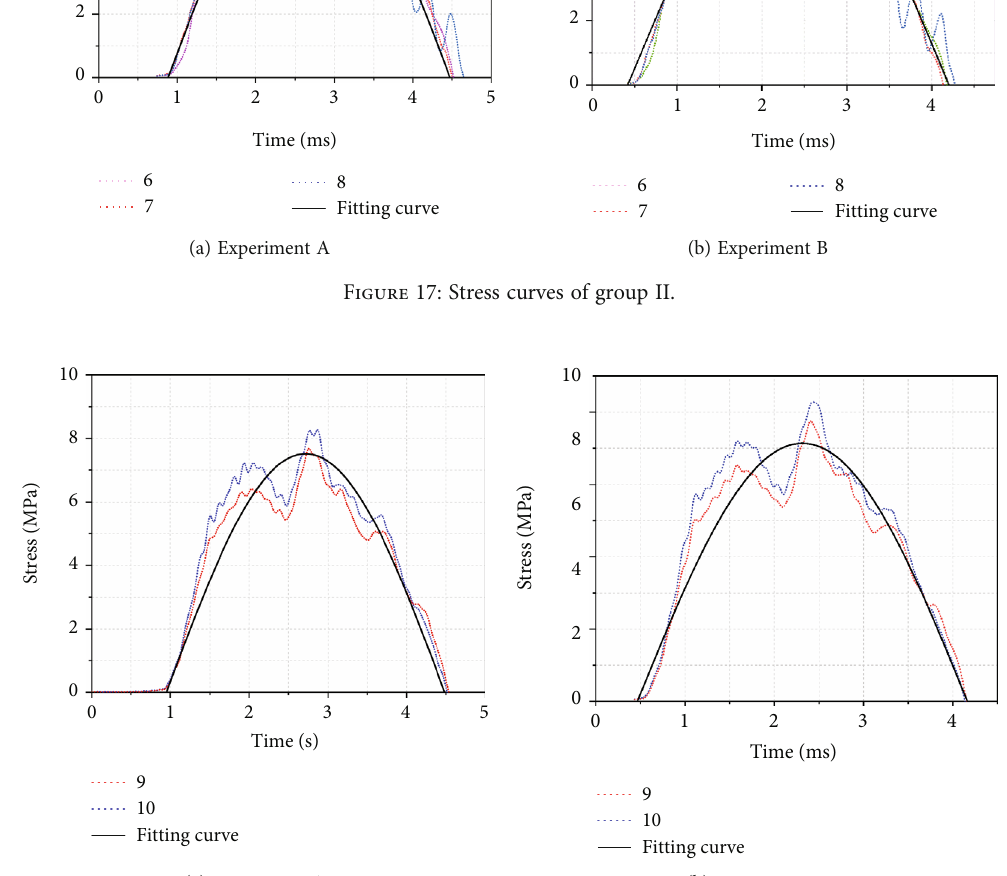
Figure 18: Stress curves of group